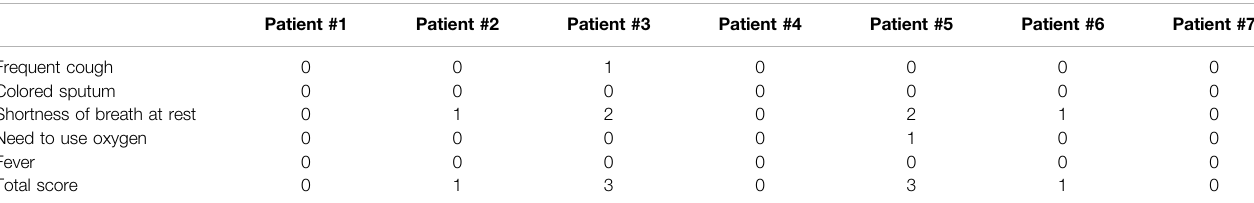
TABLE 2 | Evaluation for relieving symptoms 2 weeks after ruxolitinib administration using